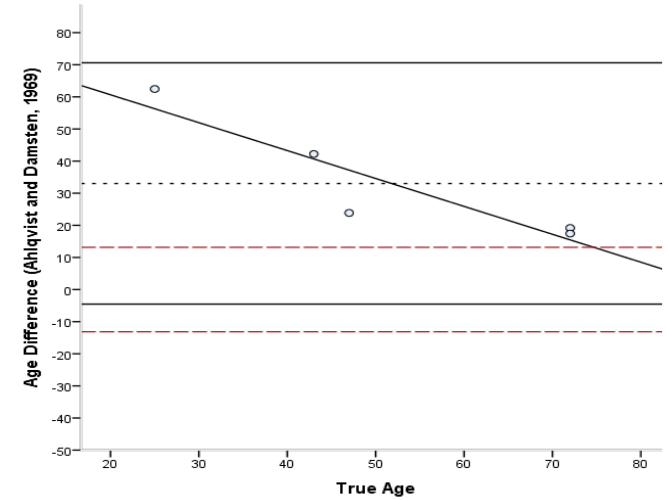
Figure 9. Bland–Altman plot for Alhqvist and Damsten’s [34] method illustrating the differences between known and estimated ages for the femora against the known age. Depicted are 95% limits of agreement (black horizontal lines), mean difference/bias (black dotted line), best fit lines and 95% confidence intervals of the SEE for each method (dashed lines). R 2 of the best fit line: 0.840.